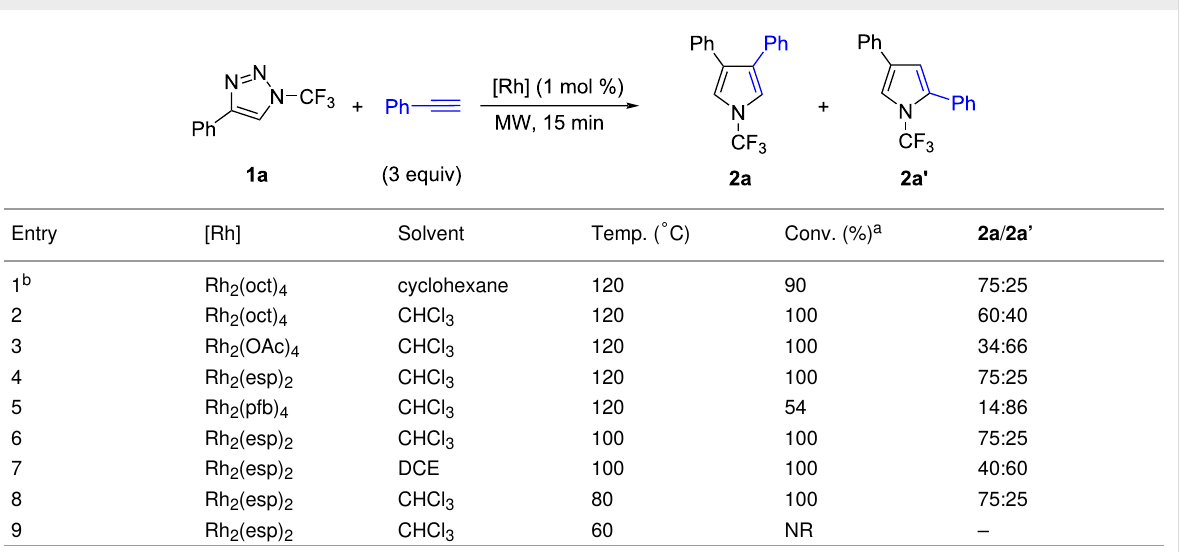
Table 1: Reaction conditions screening of the transannulation of triazole 1a with phenylacetylene.